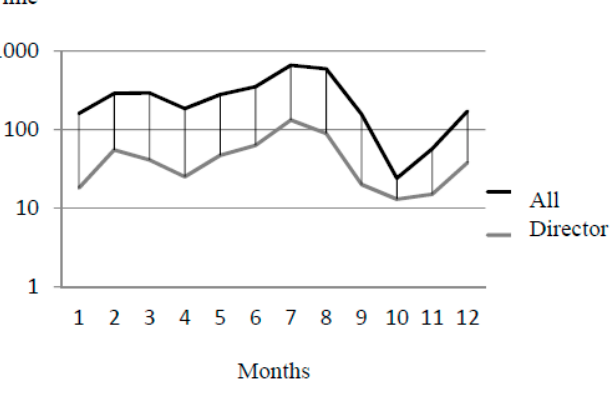
Figure 5. Monthly message sending time frequency.